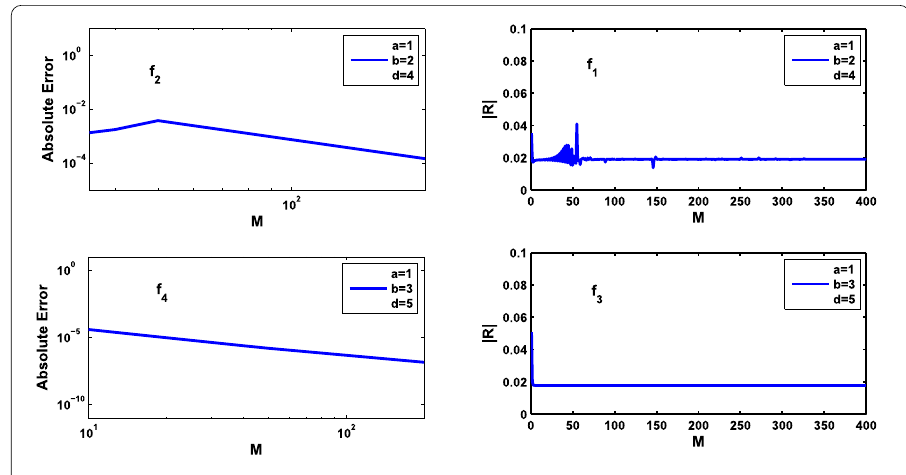
Figure 2 Reflected field amplitude | R | and absolute error versus the truncation number M